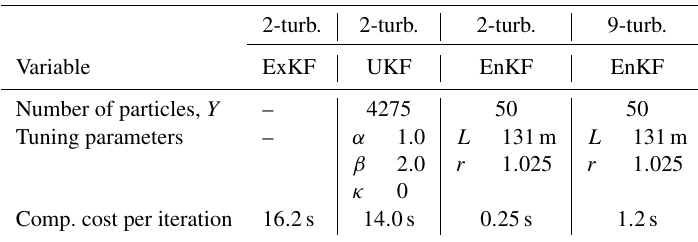
Table 3. Choice of tuning parameters for the KF variants, for both the two-turbine and nine-turbine simulation case. Note that the ExKF does not support power measurements nor parameter estimation due to the lack of linearization, and does not have any additional tuning parameters. In terms of computational cost: simulations were run on a single node using 8 cores in parallel.